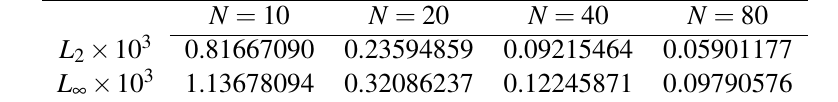
Table 5 Comparison of results at t f = 1 . 0 for γ = 0 . 5, ∆ t = 0 . 0001, ν = 1 . 0 and various mesh sizes